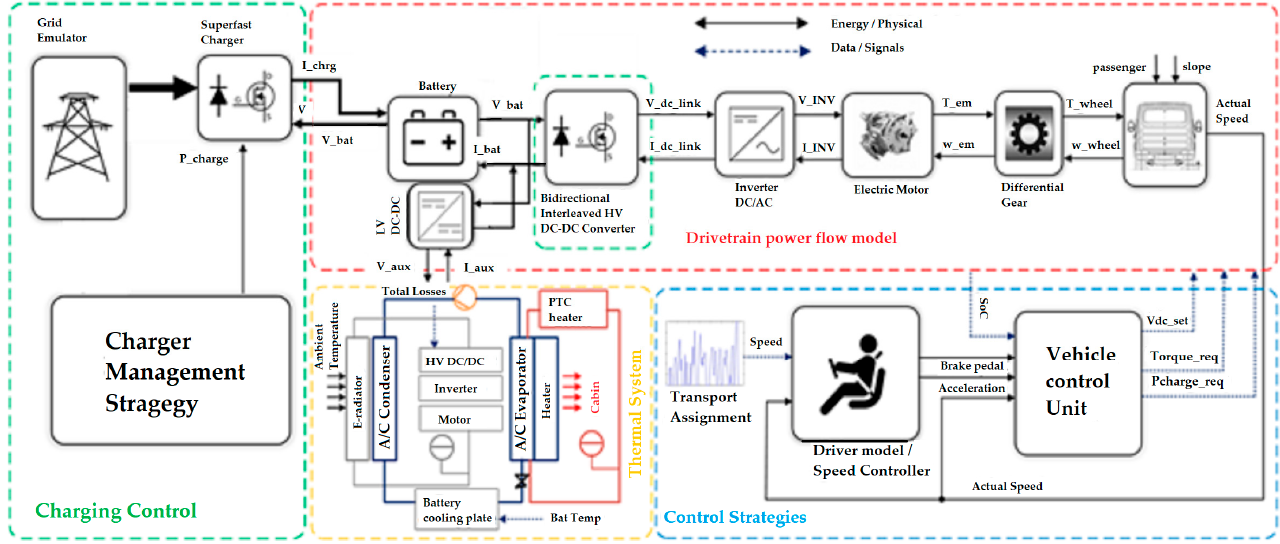
Figure 1. Overview of the simulation framework illustrating the forward ‐ facing e ‐ bus powertrain and grid infrastructure.